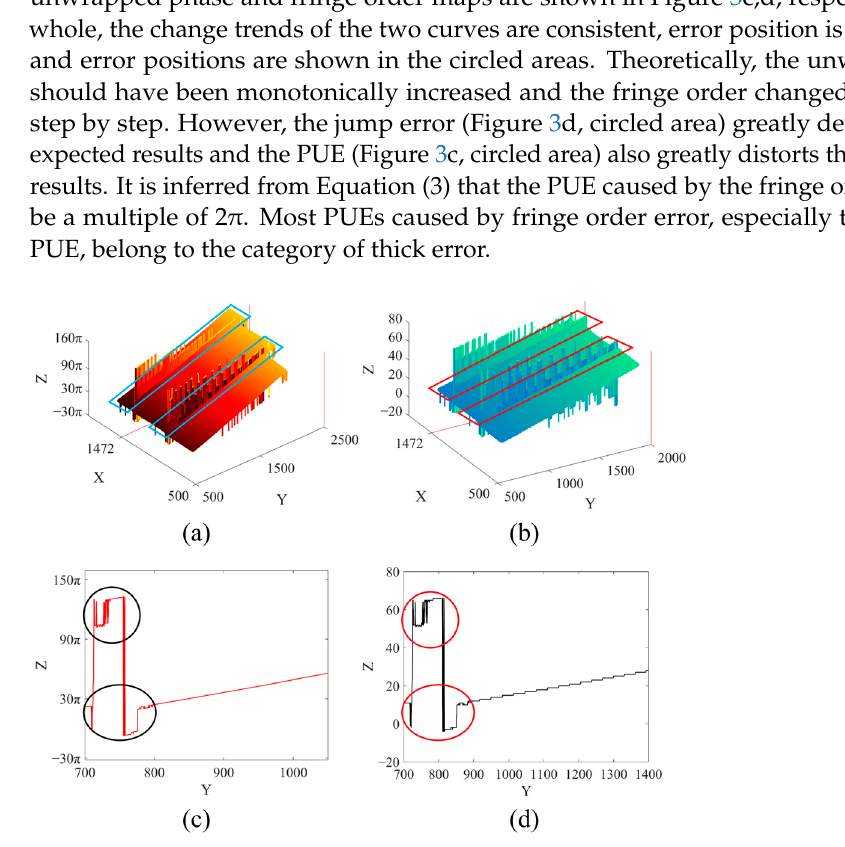
Figure 3. PUE caused by fringe order error: ( a ) Unwrapped phase map; ( b ) Fringe order map; ( c ) Unwrapped phase map on section of X = 1472; ( d ) Fringe order map on the section of X = 1472.